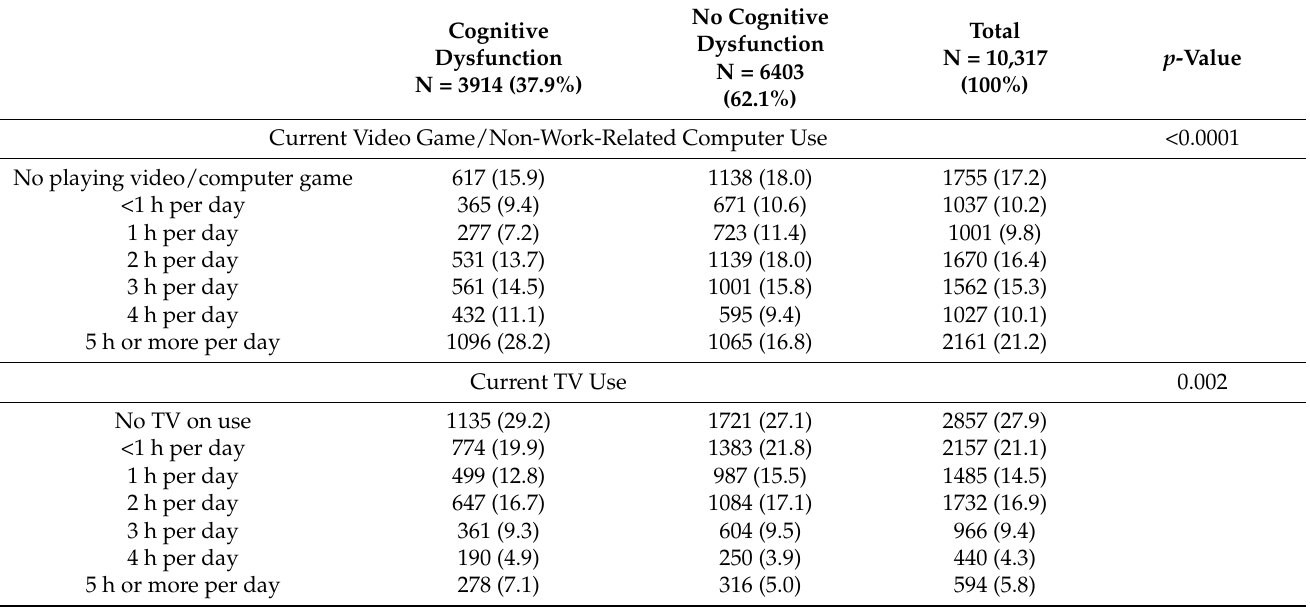
Table 2. Prevalence of cognitive dysfunction among U.S. high school students with daily digital screen time-YRBSS 2019.